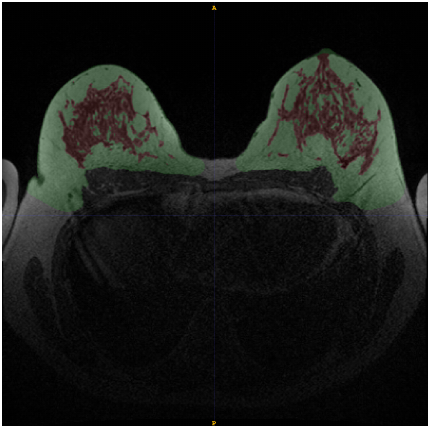
Figure 2. Example of manual annotation of fat tissue (green) and FGT (red) in WOFS